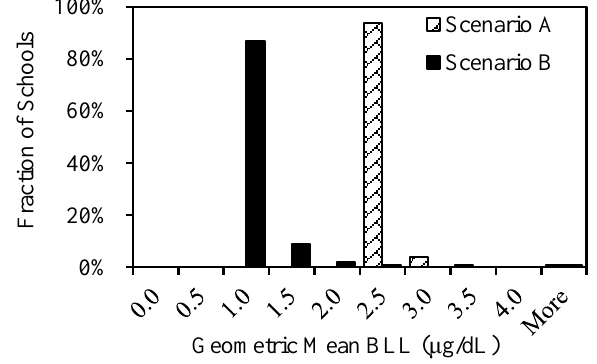
Figure 1. Distribution of BLL geometric means for elementary schools.